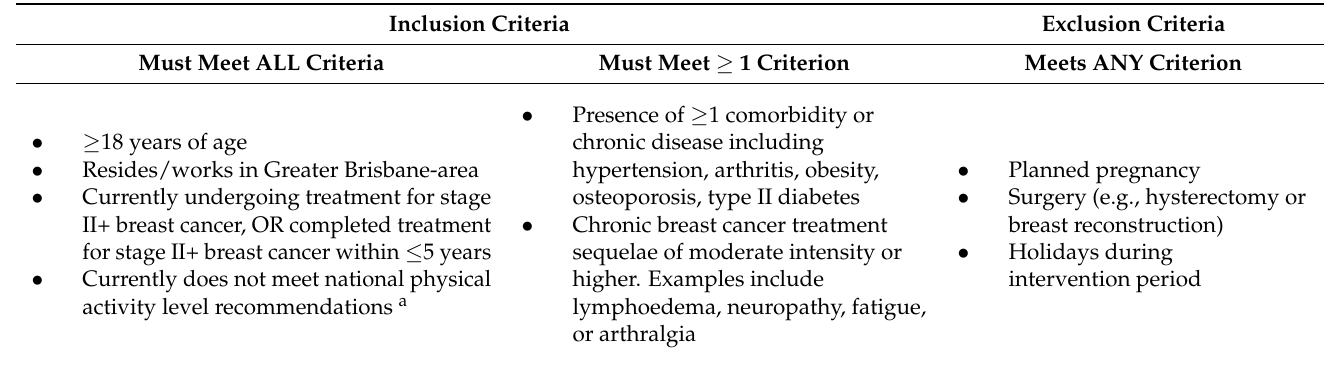
Table 1. Participant Eligibility